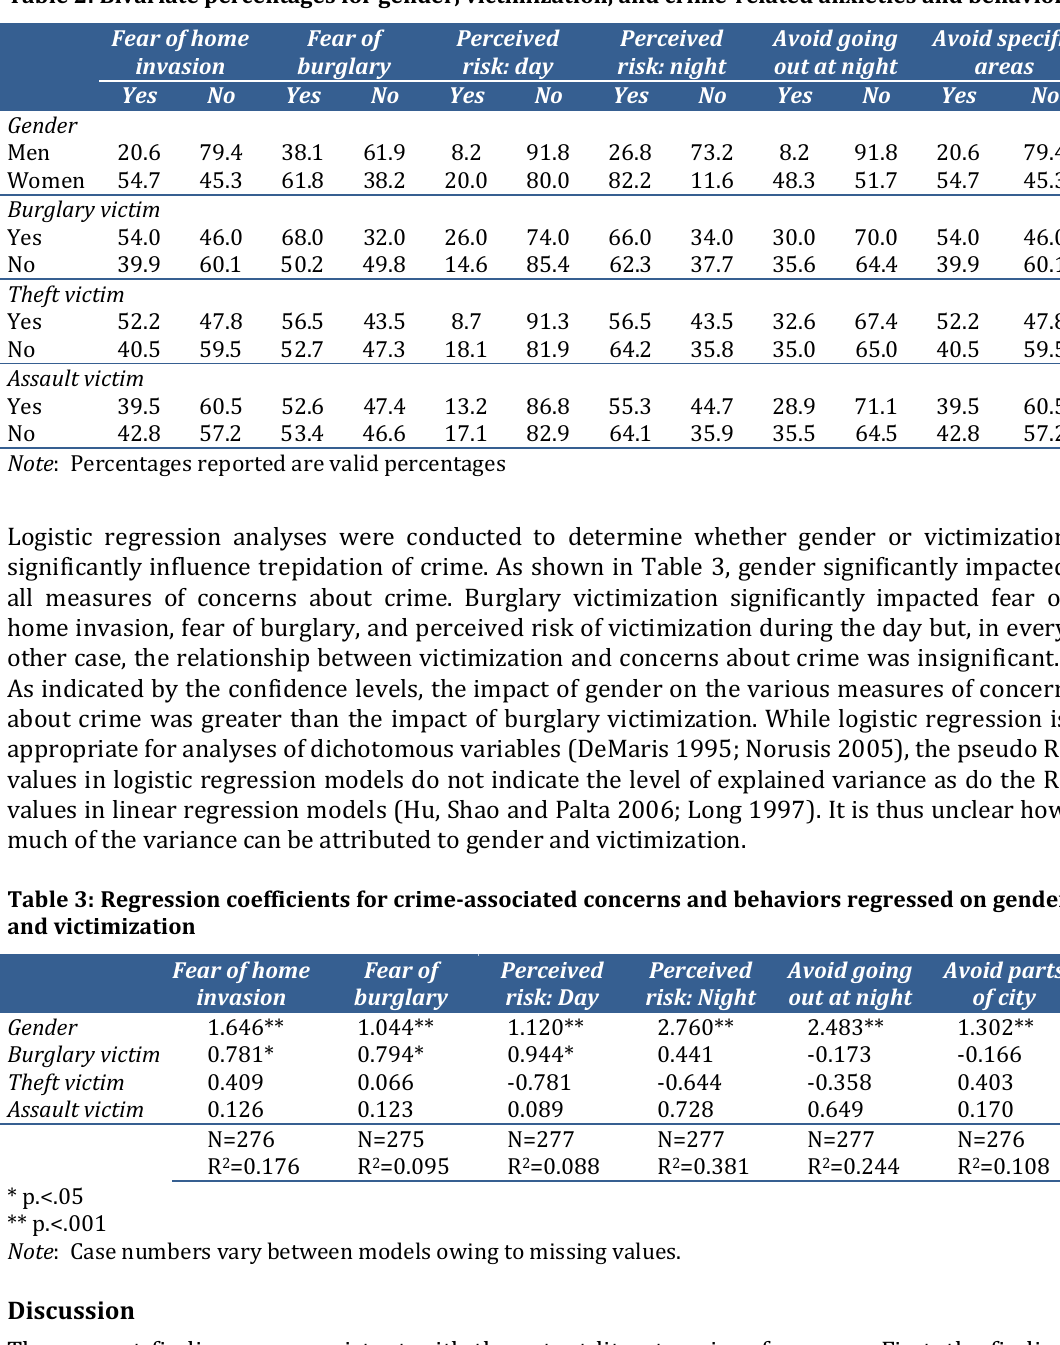
Table 2: Bivariate percentages for gender, victimization, and crime ‐ related anxieties and behaviors Fear of home Fear of Perceived Perceived Avoid going Avoid specific invasion burglary risk: day risk: night out at night areas